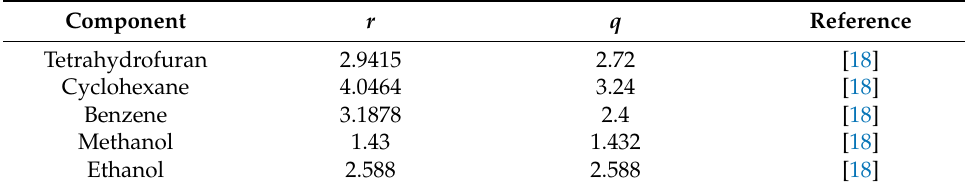
Table 3. Structural parameters for the UNIFAC